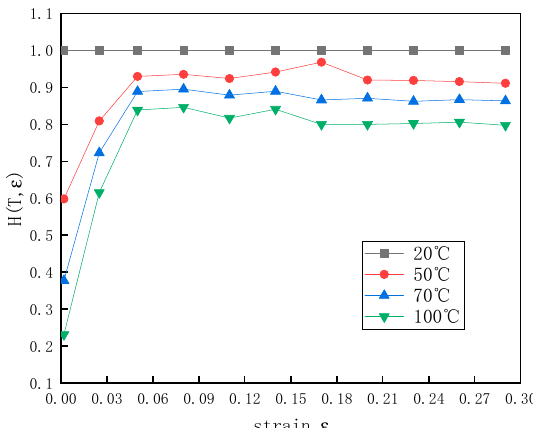
Figure 10. The relationship between H ( ε , T ) and ε at a strain rate of 1300 s − 1 and di ff erent temperatures.